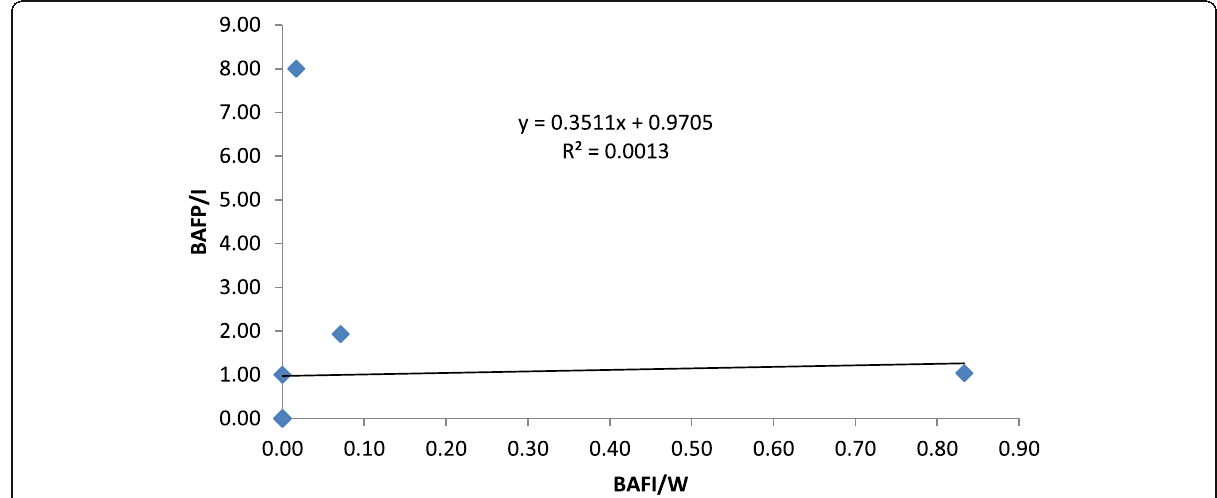
Fig. 3 Linear regression of bioaccumulation factor of OCP in parasite relative to intestine against bioaccumulation in intestine relative to